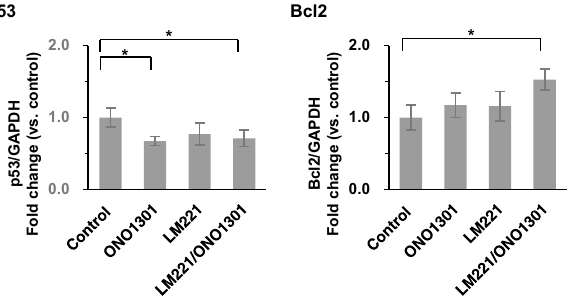
Figure 3. Combined administration of LM221 and ONO1301 decreased cell apoptosis. The expression of p53 , Bcl2 in the infarcted area was measured by quantitative reverse-transcription polymerase chain reaction. Data were normalised to GAPDH expression. * p < 0.05.